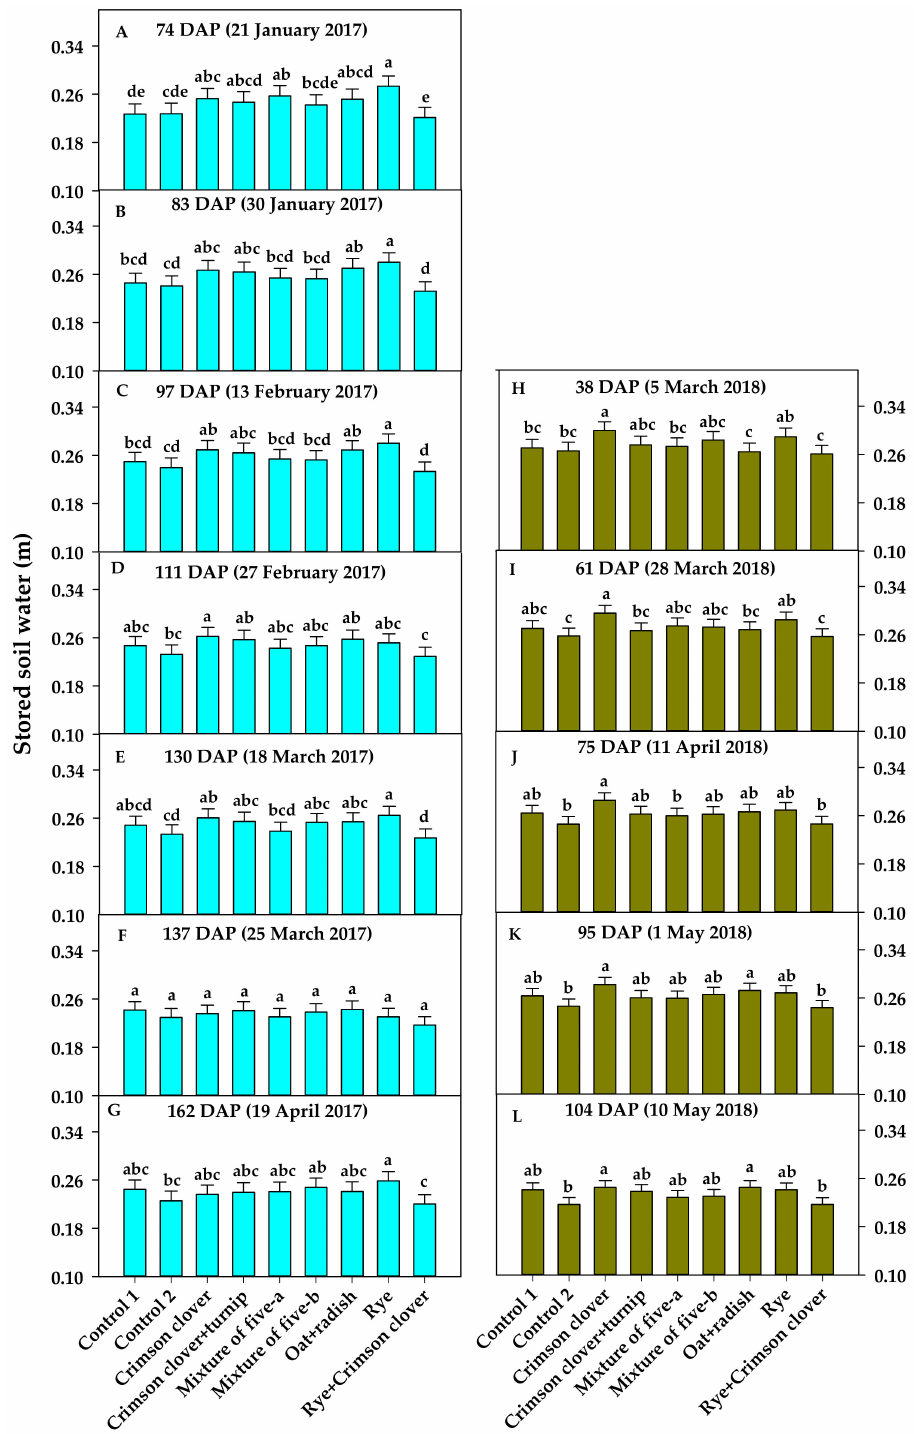
Figure 4. Total stored soil water in 60 cm depth under each of the seven cover crop treatments and two control treatments (Fallow with herbicide application (control-1) and fallow without herbicide application(control-2))onmultiplemeasurementdatesduring( A – G )thecovercropseason-1(2016–2017) and ( H – L ) season-2 (2018). Bars (least squares means) with di ff erent letters are significantly di ff erent according to the least significant di ff erence (LSD) test at α = 0.05. Mixture of five-a was a combination of Austrian winter pea, rye, crimson clover, hairy vetch, and oat. Mixture of five-b was a combination of oat, wheat, crimson clover, radish, and